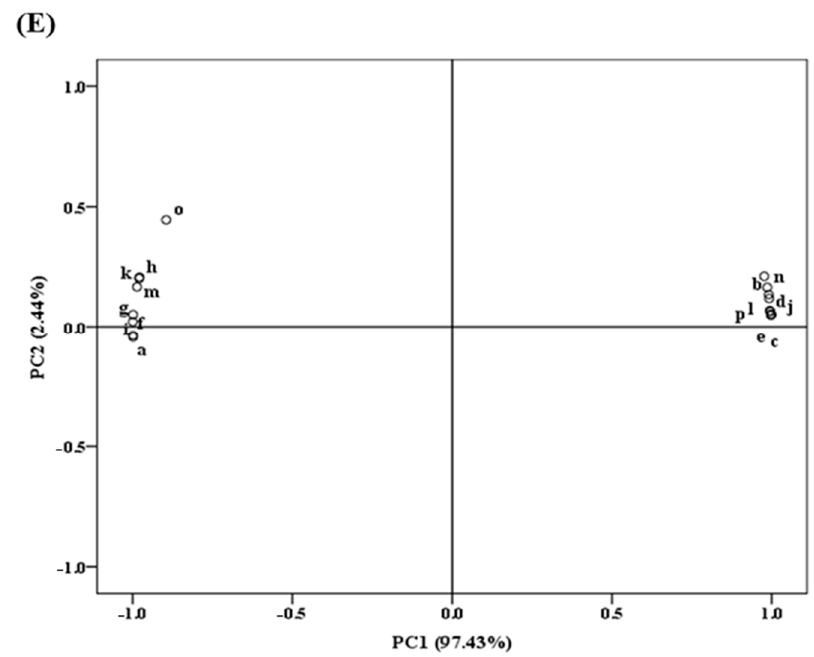
Figure 5. Chromatogram of SHs flour after PT-GC-MS analysis (Note: The letters refer to the volatile compounds listed in (Table 1). The red letters represented the volatile compounds always existed in SHs-0 h and SHs-30 h. The black letters represented the volatile compounds disappeared or generated during moisture absorption): ( A ) Chromatogram of SHs-0 h ( B ) Chromatogram of SHs-30 h. ( C ) The concentration of volatile compounds existed in SHs-0 h and SHs-30 h. ( D ) Hierarchical cluster analysis of SHs-0 h and SHs-30 h was analyzed basing on the standardized peak areas of volatile compounds. ( E ) The principal component analysis (PCA) scores plot.